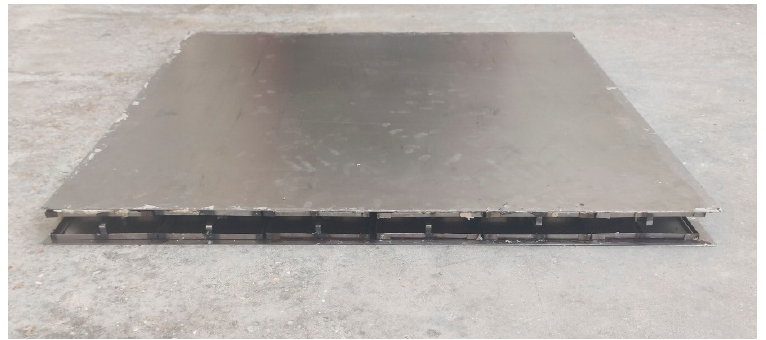
Figure 8. Tested Metasolution sample consisting of the combination of elastic structure and external steel panels.